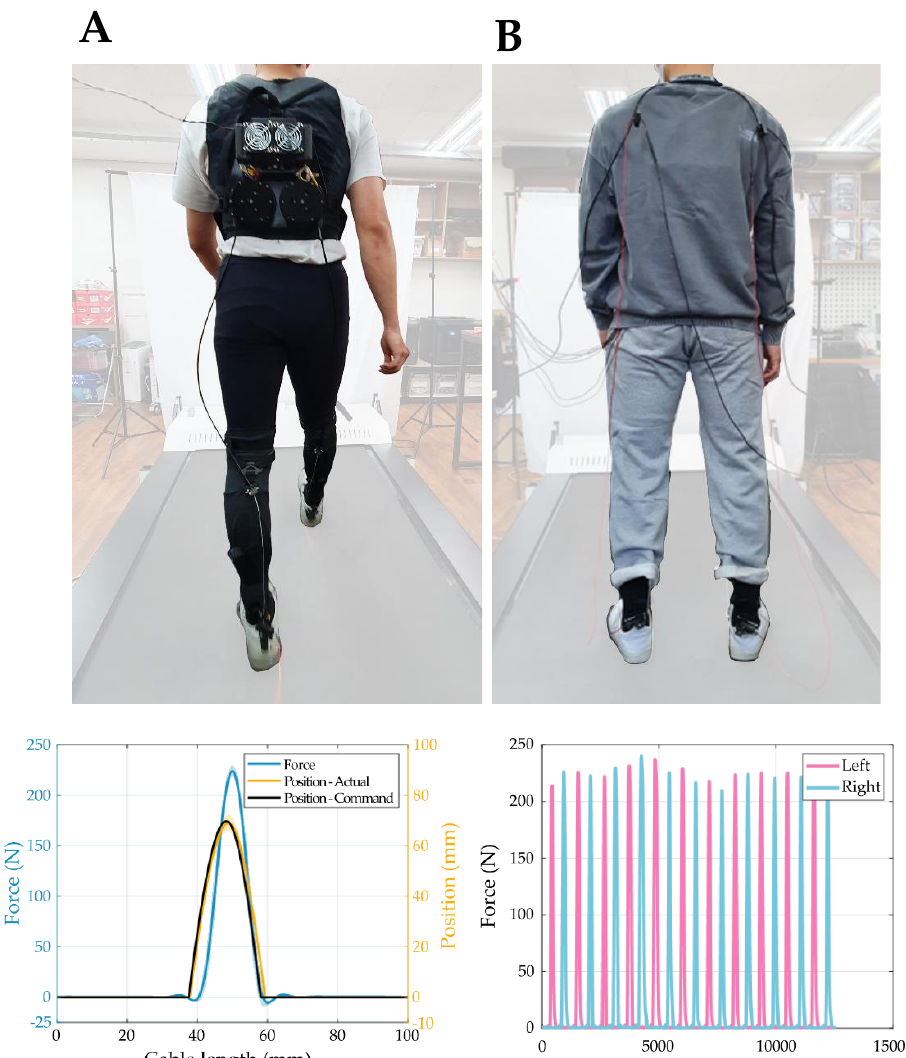
Figure 10. ( A ) A walking test through a combination with a mobile actuator can demonstrate the advantages of the lighter and simpler design of kneE-XOcks. ( B ) It can be worn under everyday clothes and driven without difficulty. From the result graph, it can be seen that the kneE-XOcks can operate without any issues as an ankle exosuit even when combined with a mobile actuator.